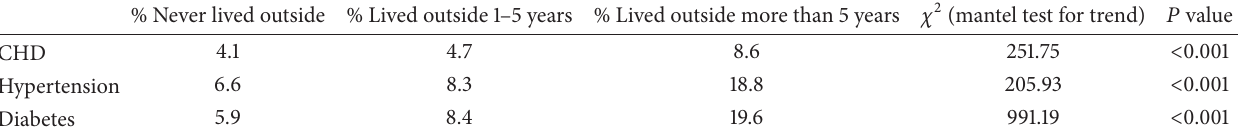
Table 3: Duration of migration and prevalence of selected chronic